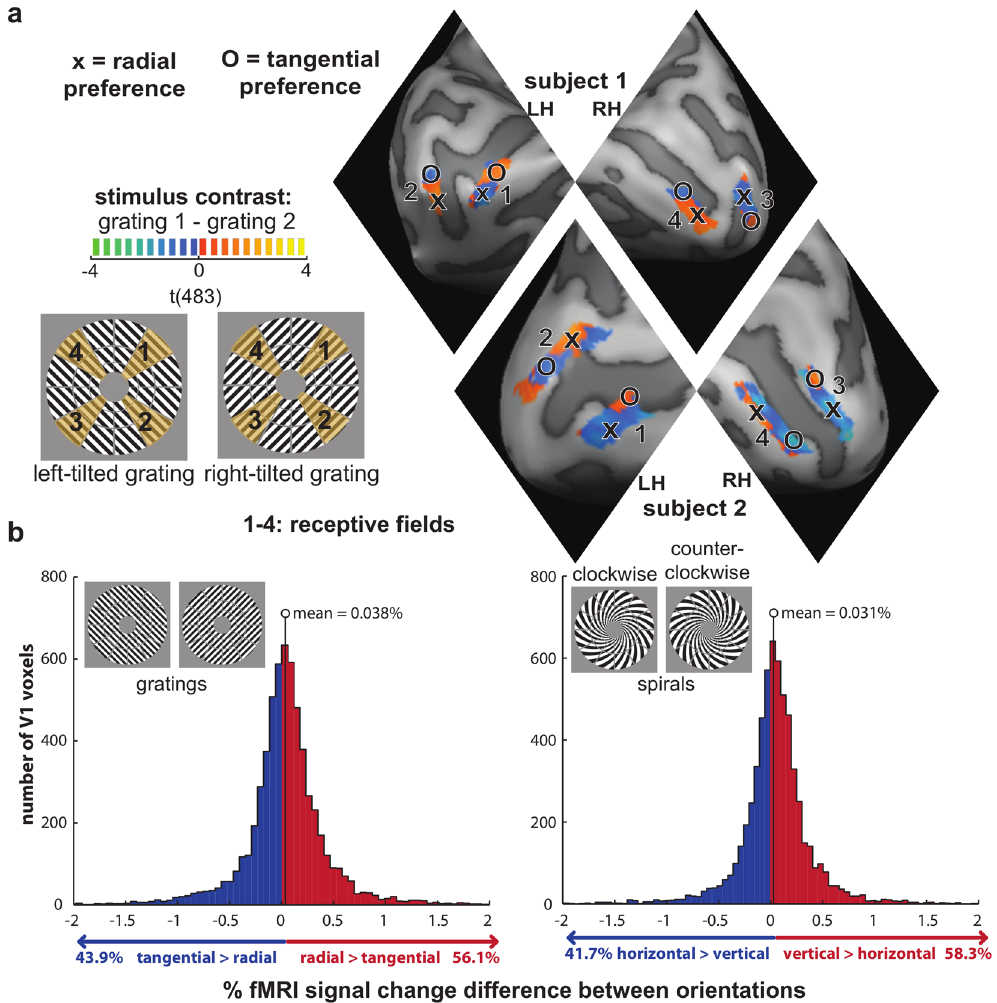
Figure 2. Opposite orientation preferences intermingle within quarterfield patches in V1. ( a ) A visualization of how fMRI voxels were labeled as preferring radial and tangential orientation. The contrast t maps indicate the activation difference between the two displayed visual gratings. Activation is only shown for the four within-quarterfield ROIs, which are labeled clockwise from 1 to 4. Positive and negative t-values indicate either a radial or a tangential preference depending on the visual field they are in. This we have clarified by labeling local activation clusters with 0 and X when they have a tangential and radial preference respectively. Note that the activation map is unthresholded and that no inferences are made based on it. ( b ) Histograms showing the distribution of V1 voxels that prefer radial vs tangential orientation (left) and vertical vs horizontal orientation (right). These plots are based on all voxels in all four quarterfield ROIs across all participants. ( c ) A visualization of the proportion of V1 voxels preferring radial orientation (left, red), tangential orientation (left, blue), vertical orientation (right, red) and horizontal orientation (right, blue) across subjects and quarterfield